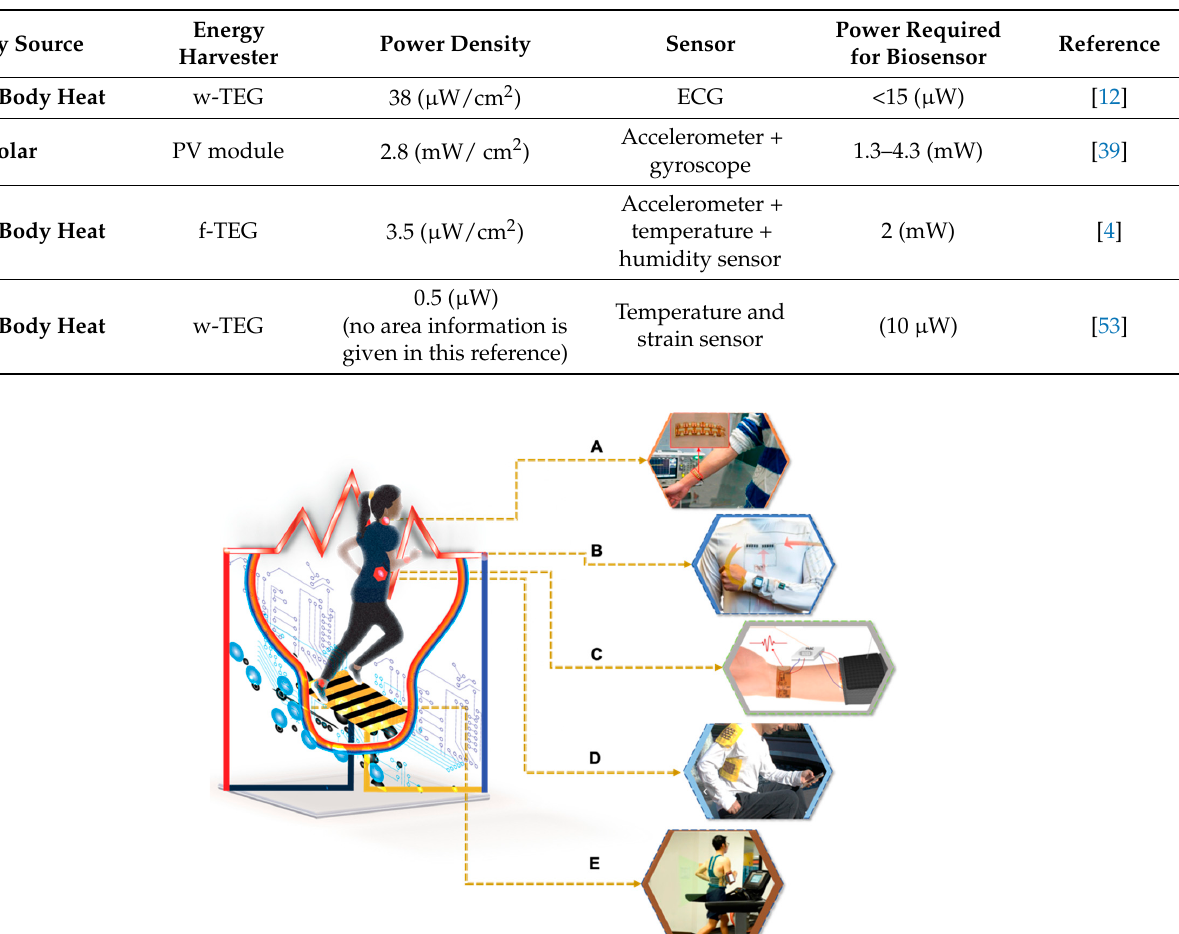
Table 1. Energy budget for WTEG-based self-powered biosensors.